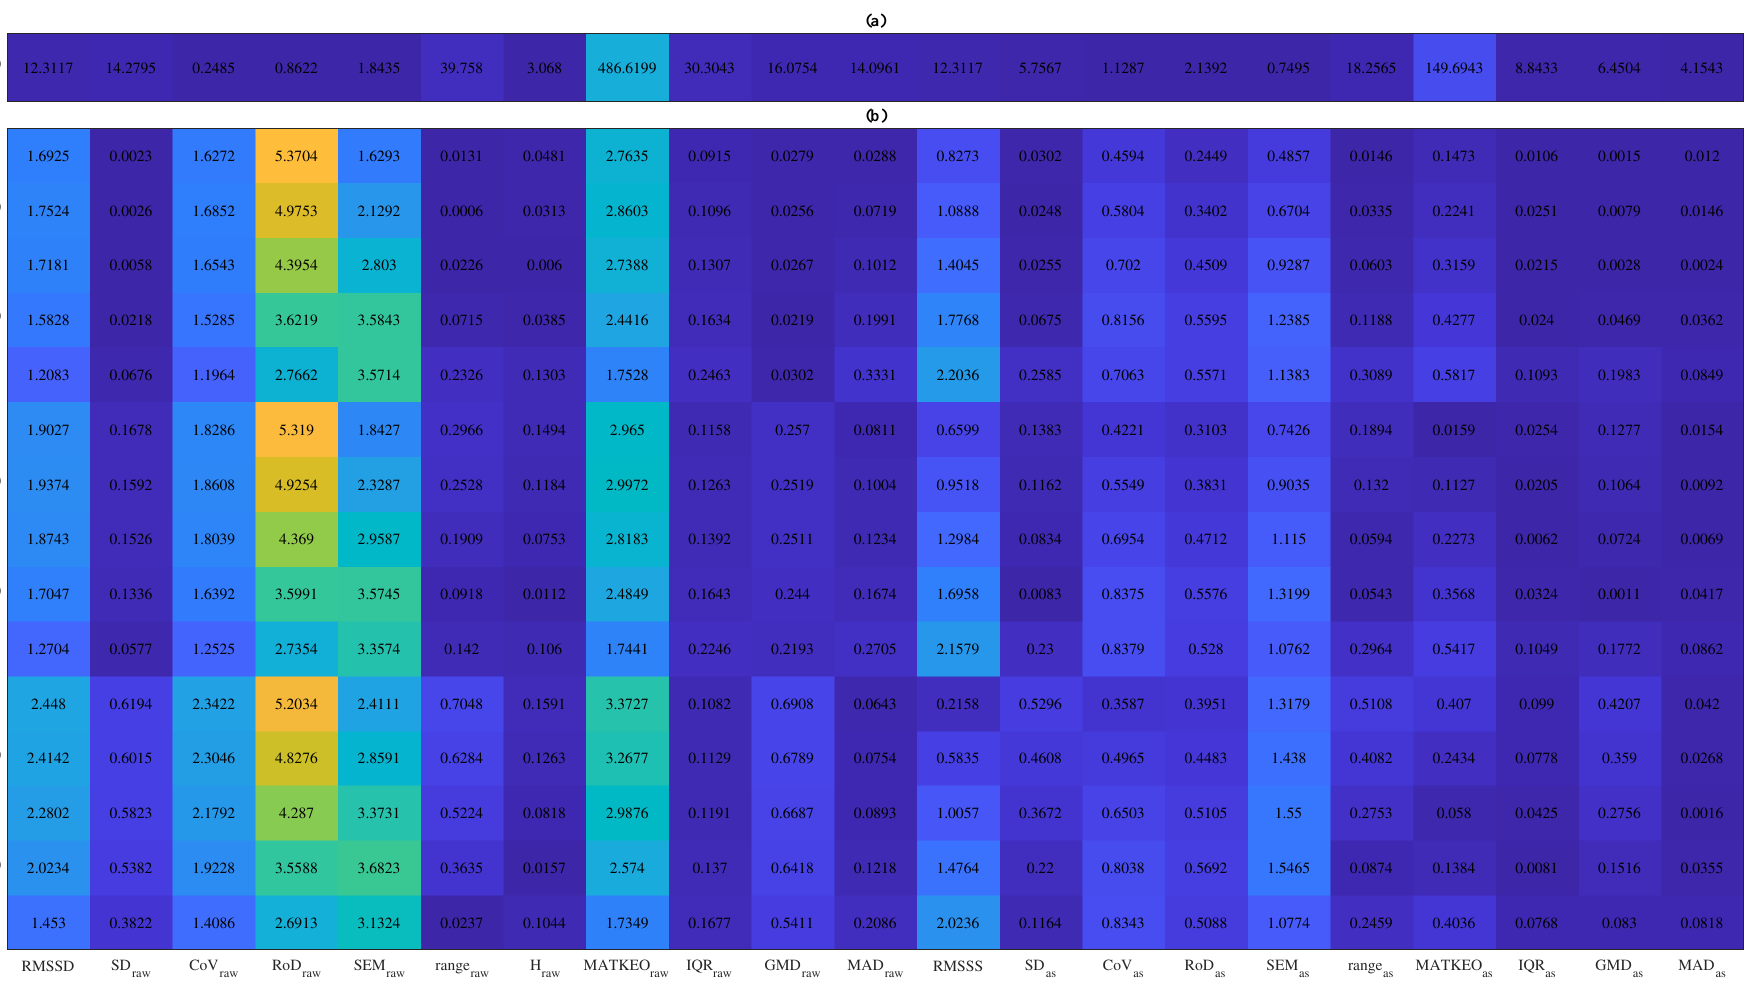
Figure 4. Results for 4000 realizations with a cosine function with amplitude 20. The meaning of all quantities can be found in the table of abbreviations. ( a ) Mean values in the favorable scenario. ( b ) Performance